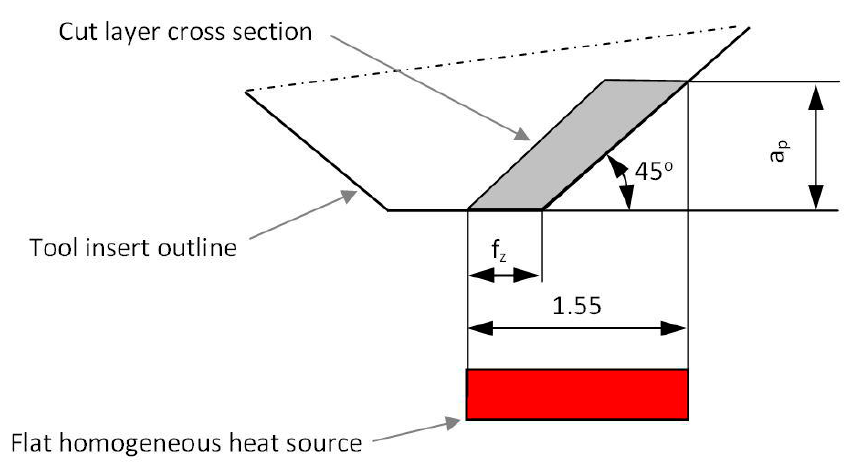
Figure 5. Determining the length of the flat source of heat for the first cutting strategy.